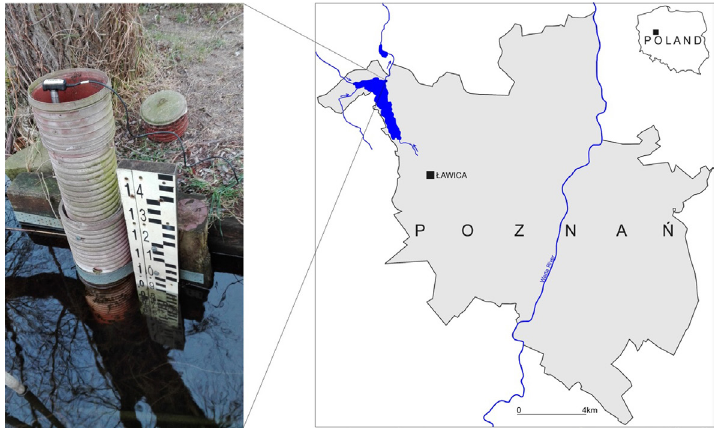
Fig. 1. Study site location. On the left: measurement site (limnimetric column and water